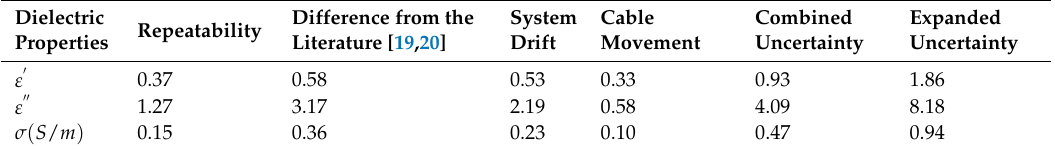
Table 1. Calculated uncertainty values for 0.1 M NaCl solutions between 0.5 and 6 GHz.